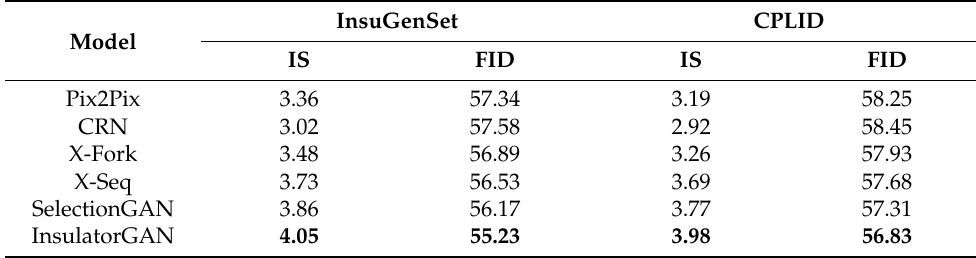
Table 3. IS and FID of the different